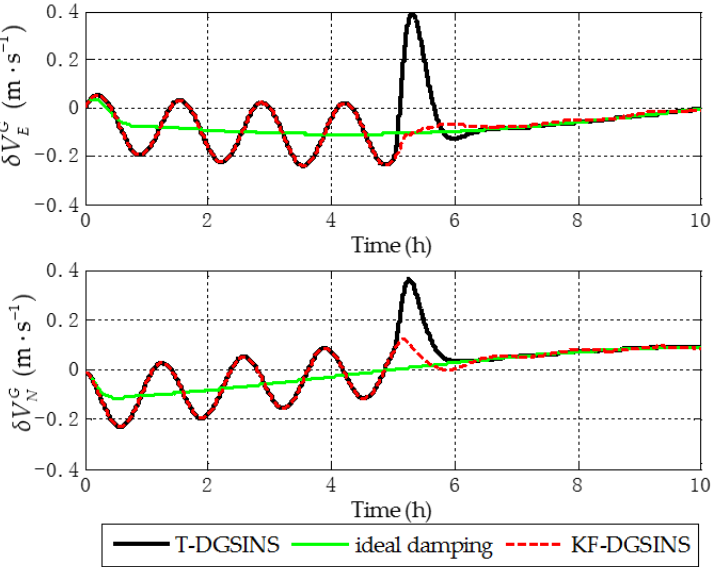
Figure 10. Grid level velocity errors of the simulation results.